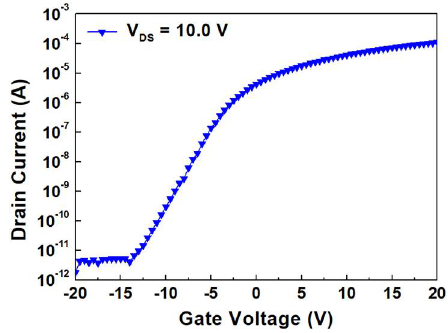
Figure 11. Transfer characteristics of the fabricated a-IGZO TFT.